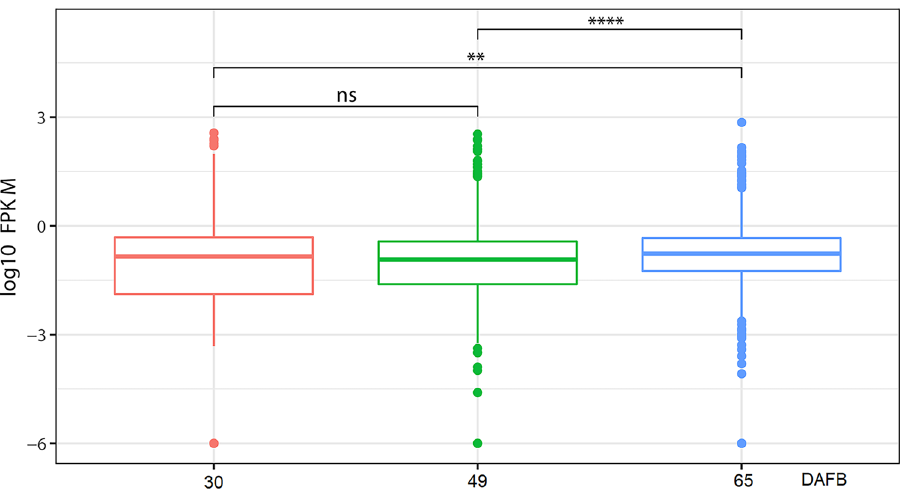
Figure 3. Overall expression levels of lncRNAs of each fruit developmental stage. ** and **** represent P < 0.01 and P < 0.0001 (Student’s t -test), respectively.